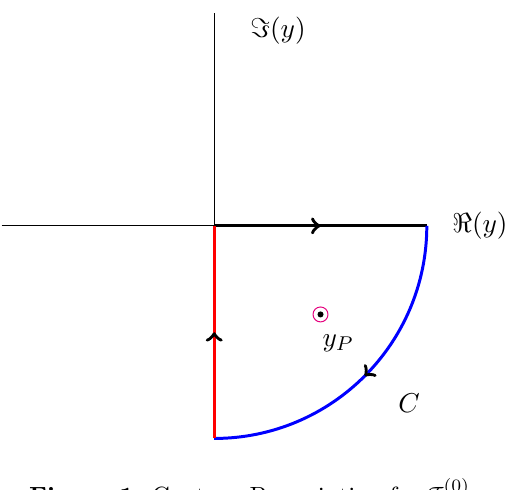
Figure 1 . Contour Prescription for I (0) o